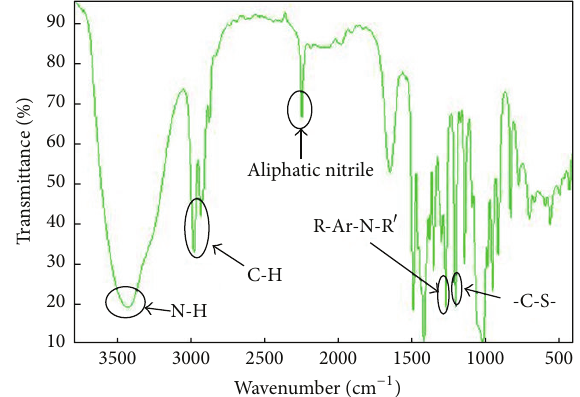
Figure 4: Infrared spectrum of synthetic